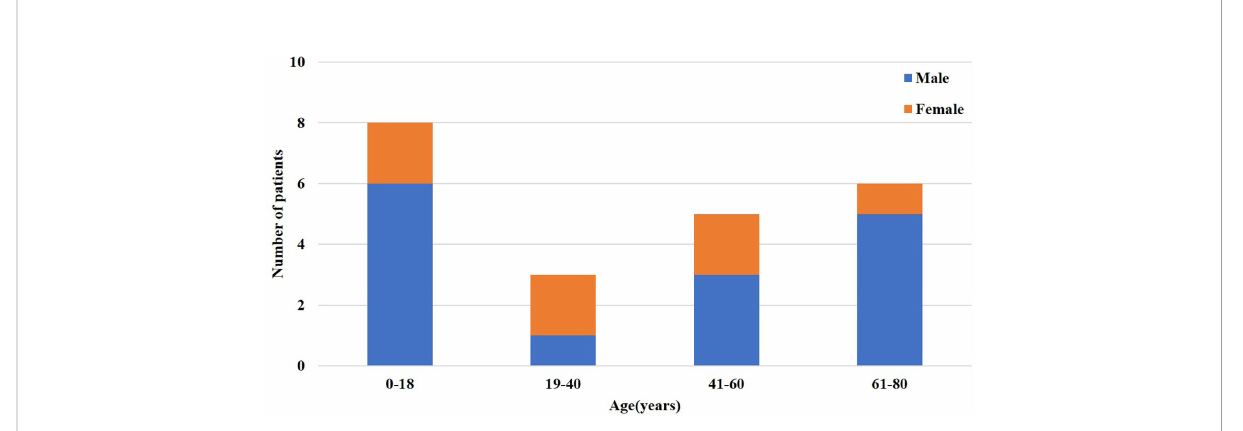
FIGURE 1 Distribution of sex and age of patients with the coexistence of multiple anti-neuronal